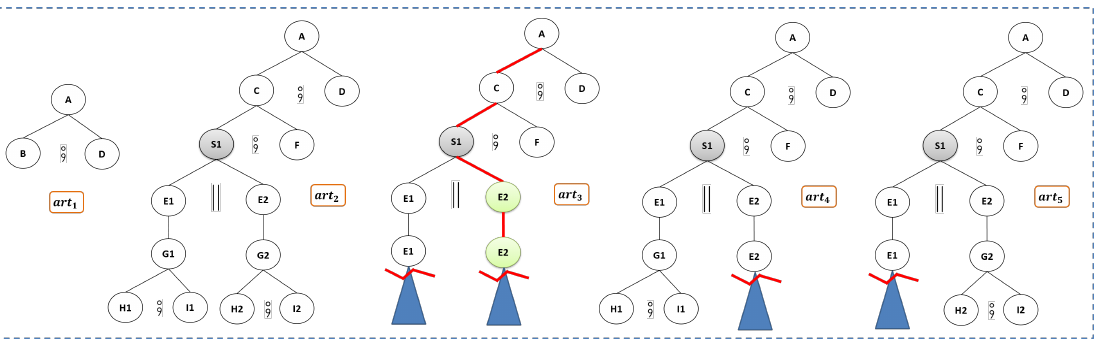
Figure 2: Representative artifacts of a paper validation process in a peer-review